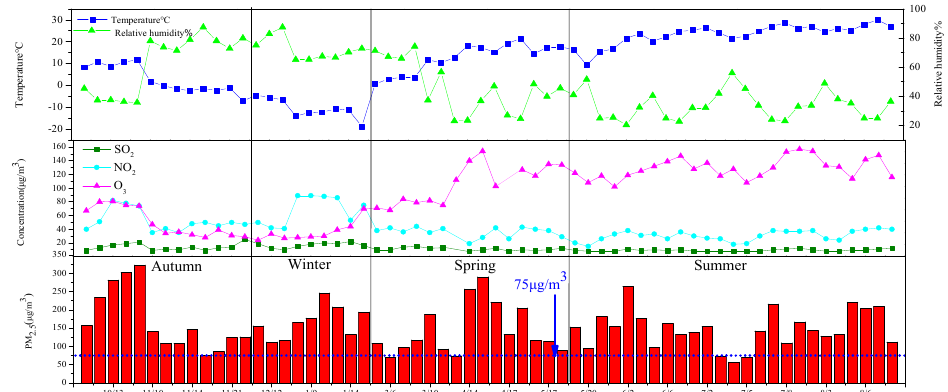
in winter, low temperatures increase the start-up time of motor vehicles and promote an increase in NO 2 [14]. The concentration of O 3 was the highest in summer, which may have been due to the high temperatures promoting the photochemical reaction of NO x and VOC in the atmosphere [15], so that the concentration of O 3 was on the rise; the PM 2.5 concentration ranged from 56.84 to 322.59 μ g/m 3 .